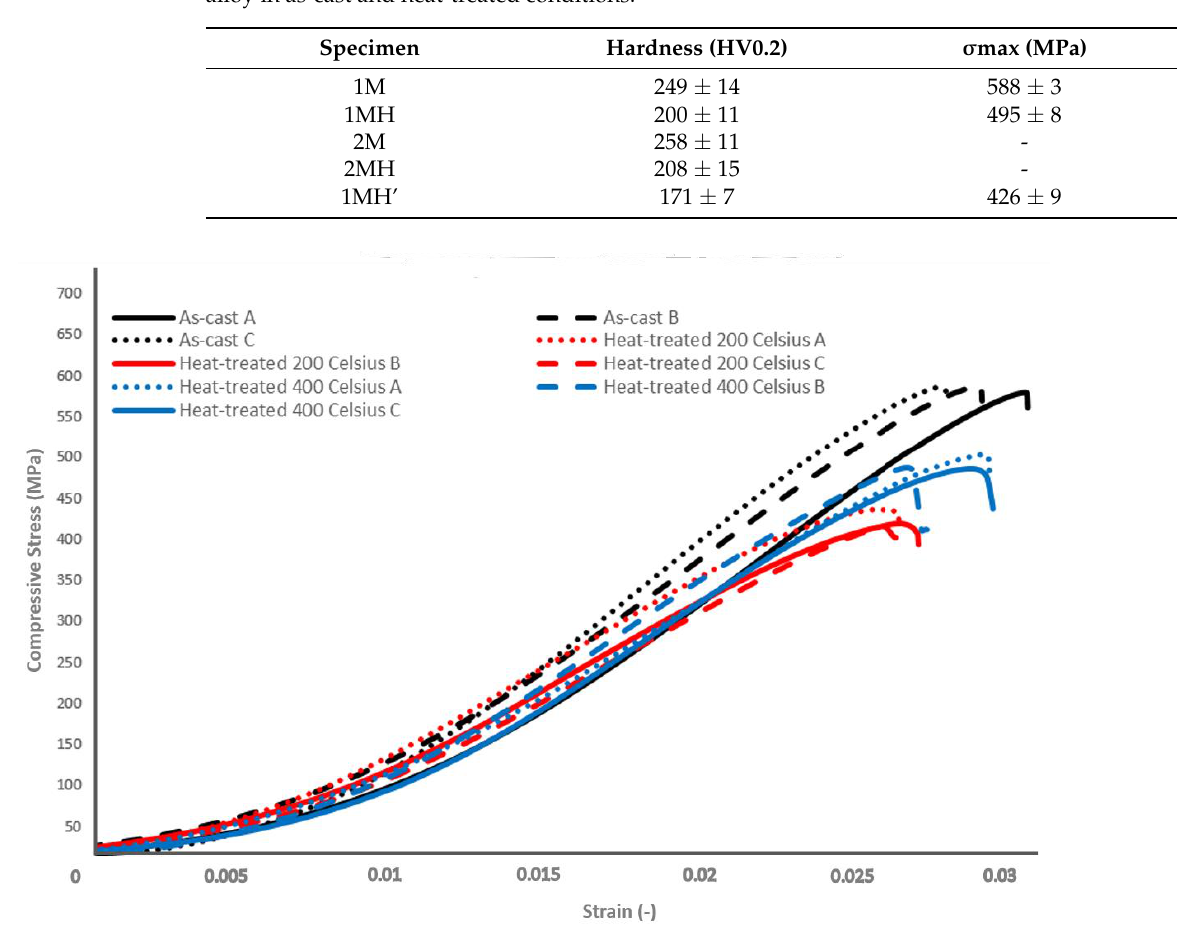
Figure 12. Compressive strength diagram. Table 10. Microhardness and maximum compressive strength average values of the manufactured alloy in as-cast and heat-treated conditions.